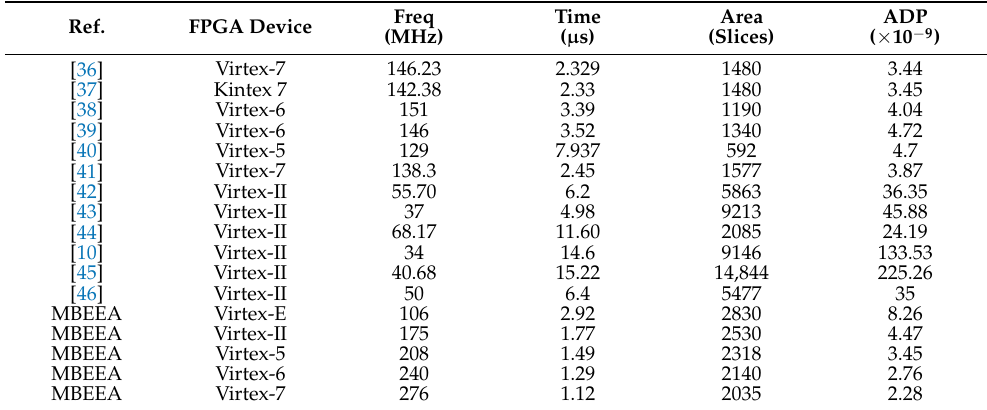
Table 5. Performance analysis of the proposed and the existing modular inversion designs over F 256 .